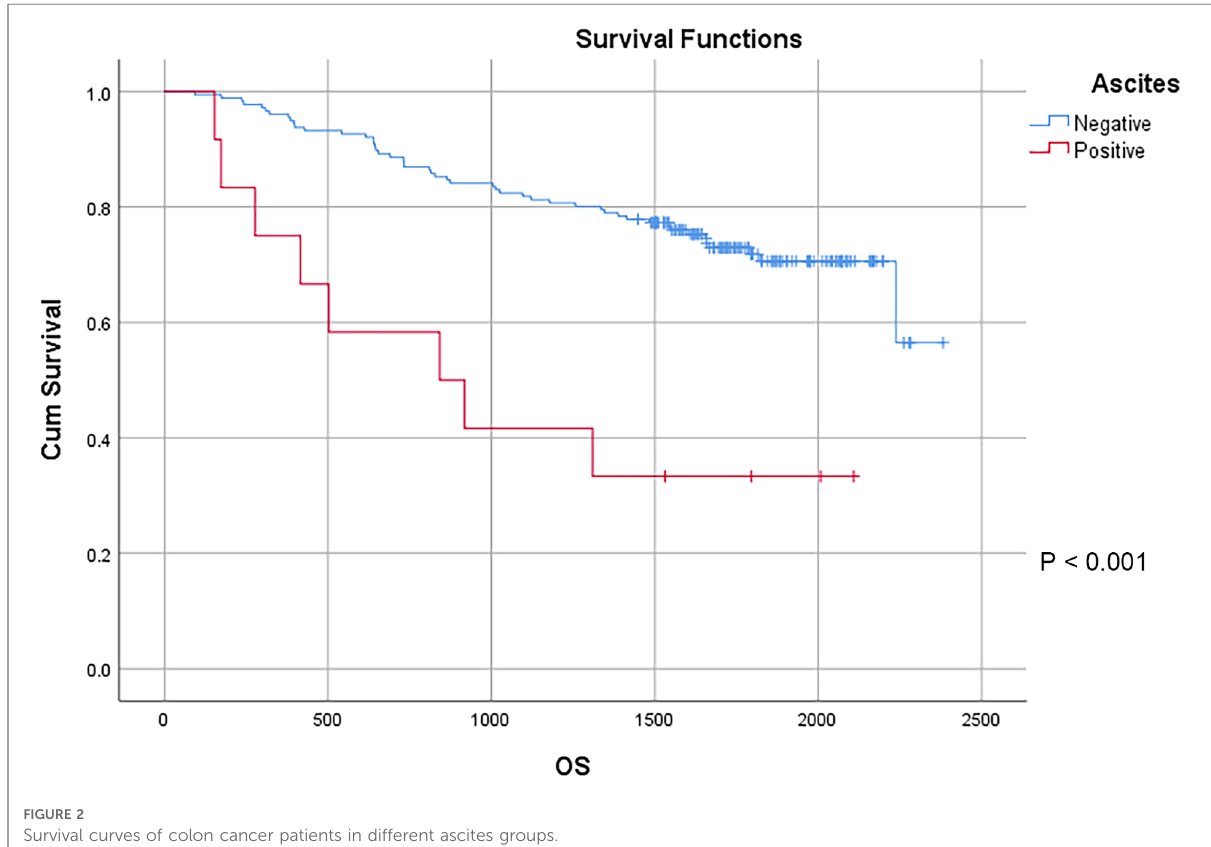
FIGURE 2 Survival curves of colon cancer patients in different ascites groups.